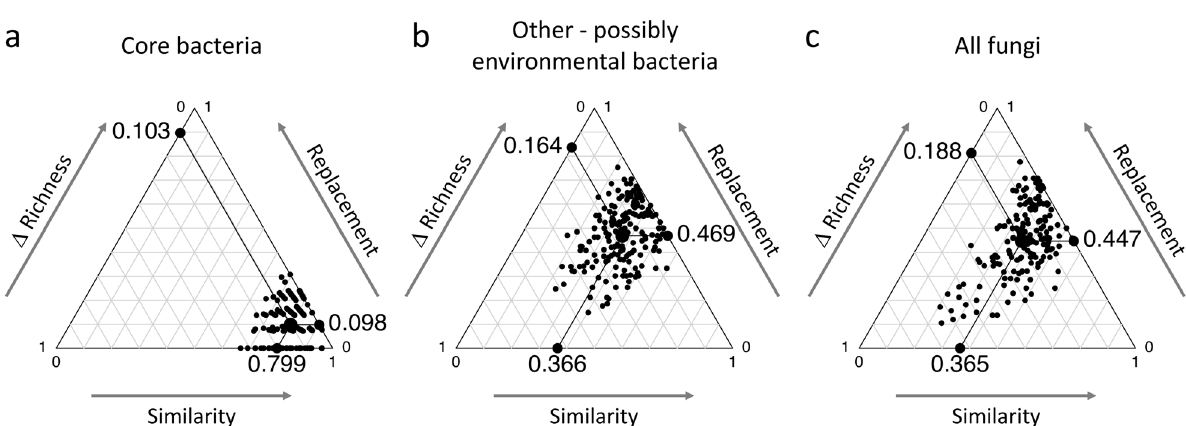
Fig. 3 Components of the microbial beta-diversity pattern. Ternary plots are used to quantify the component of the assembly along the gut compartment for ( a ) core bacteria, ( b ) other-possibly environmental bacteria, and ( c ) fungi; note the dataset presented in Fig. 2c, f, g, respectively, were used to perform this analysis. Each point in the triangle plot was determined by a triplet of values from the similarity, replacement, and richness difference components. In each ternary, large central dots from which the lines start represent the centroid of the points; the lines represent the mean values of the three components (i.e., similarity, replacement, and richness